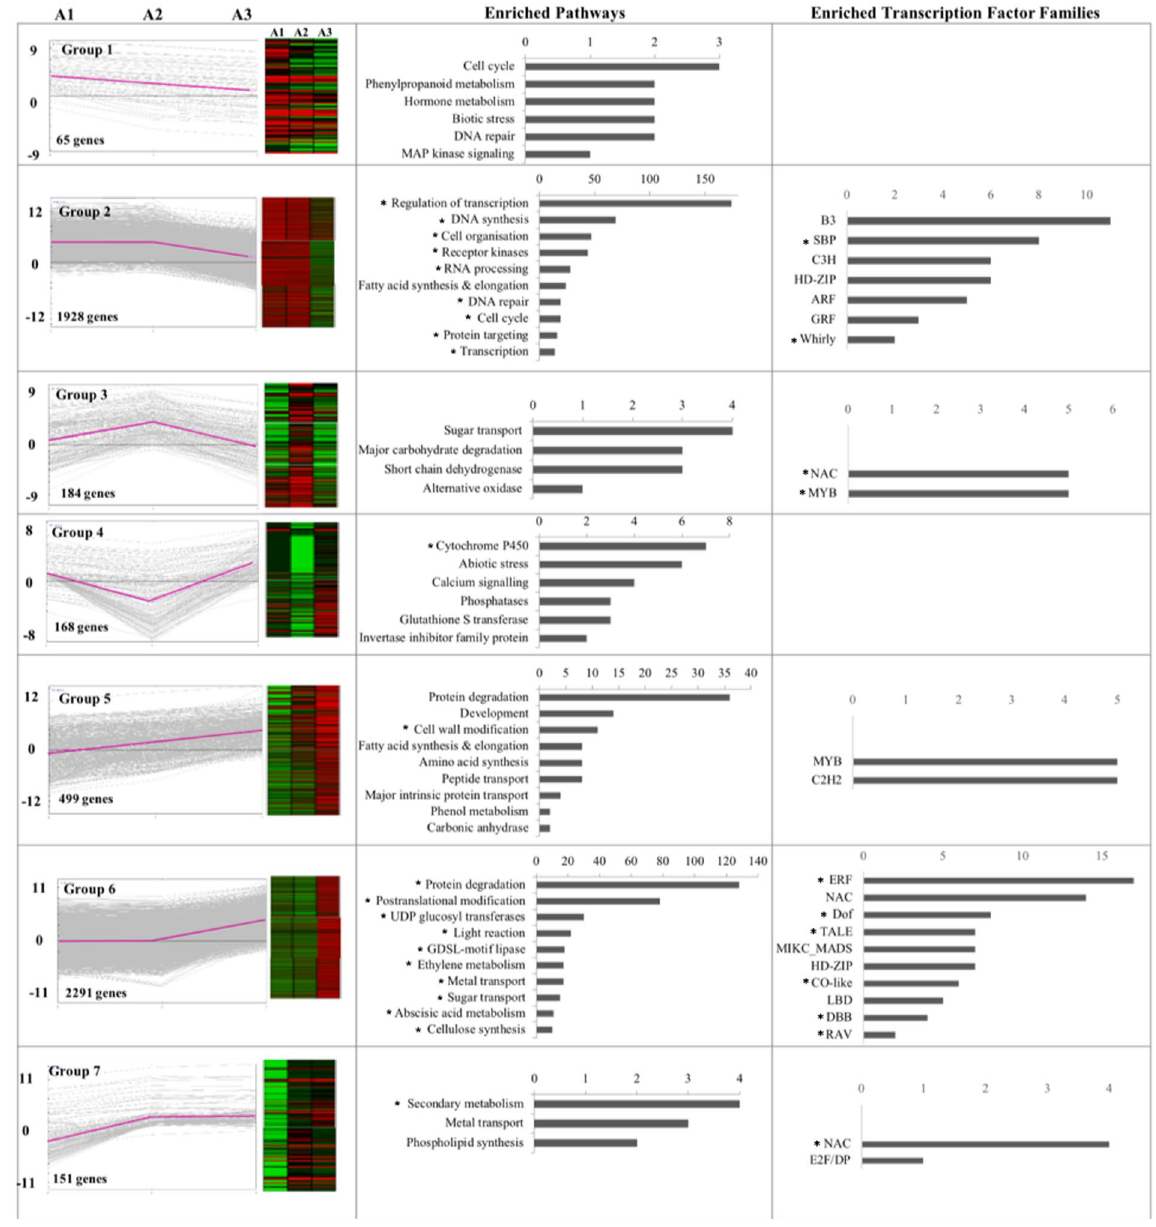
Figure 3. Dominant patterns exhibited by differentially expressed genes (DEGs), and enriched pathway sub-categories and transcription factor families. Grouping of DEGs was done based on K-means clustering and identification of enriched pathway sub-categories and transcription factor families was carried out using hypergeometric test (p-value ≤ 0.05). Top 10 pathway sub-categories have been shown for the groups containing more than 10 pathways. The asterisks are used to mark the sub-categories for which the p-value for enrichment was significant after multiple correction with Benjamini-Hochberg test (FDR <